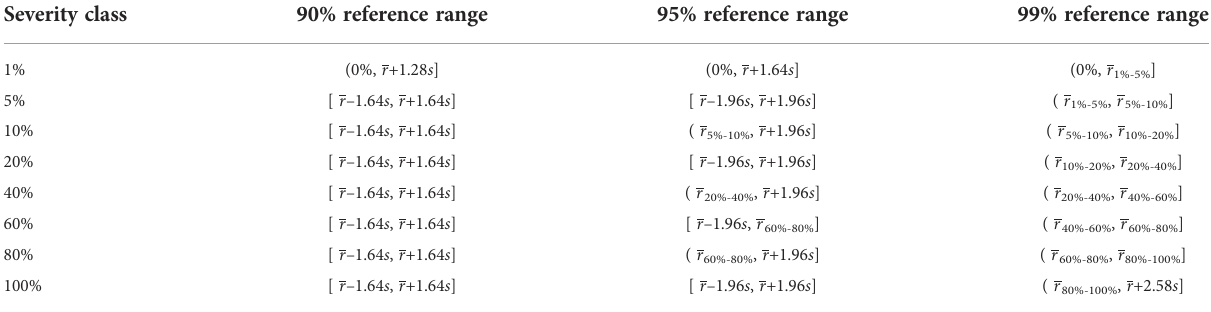
TABLE 1 Calculation methods of the 90%, 95%, and 99% reference ranges of the actual percentages of lesion areas corresponding to each severity class of wheat stripe rust.